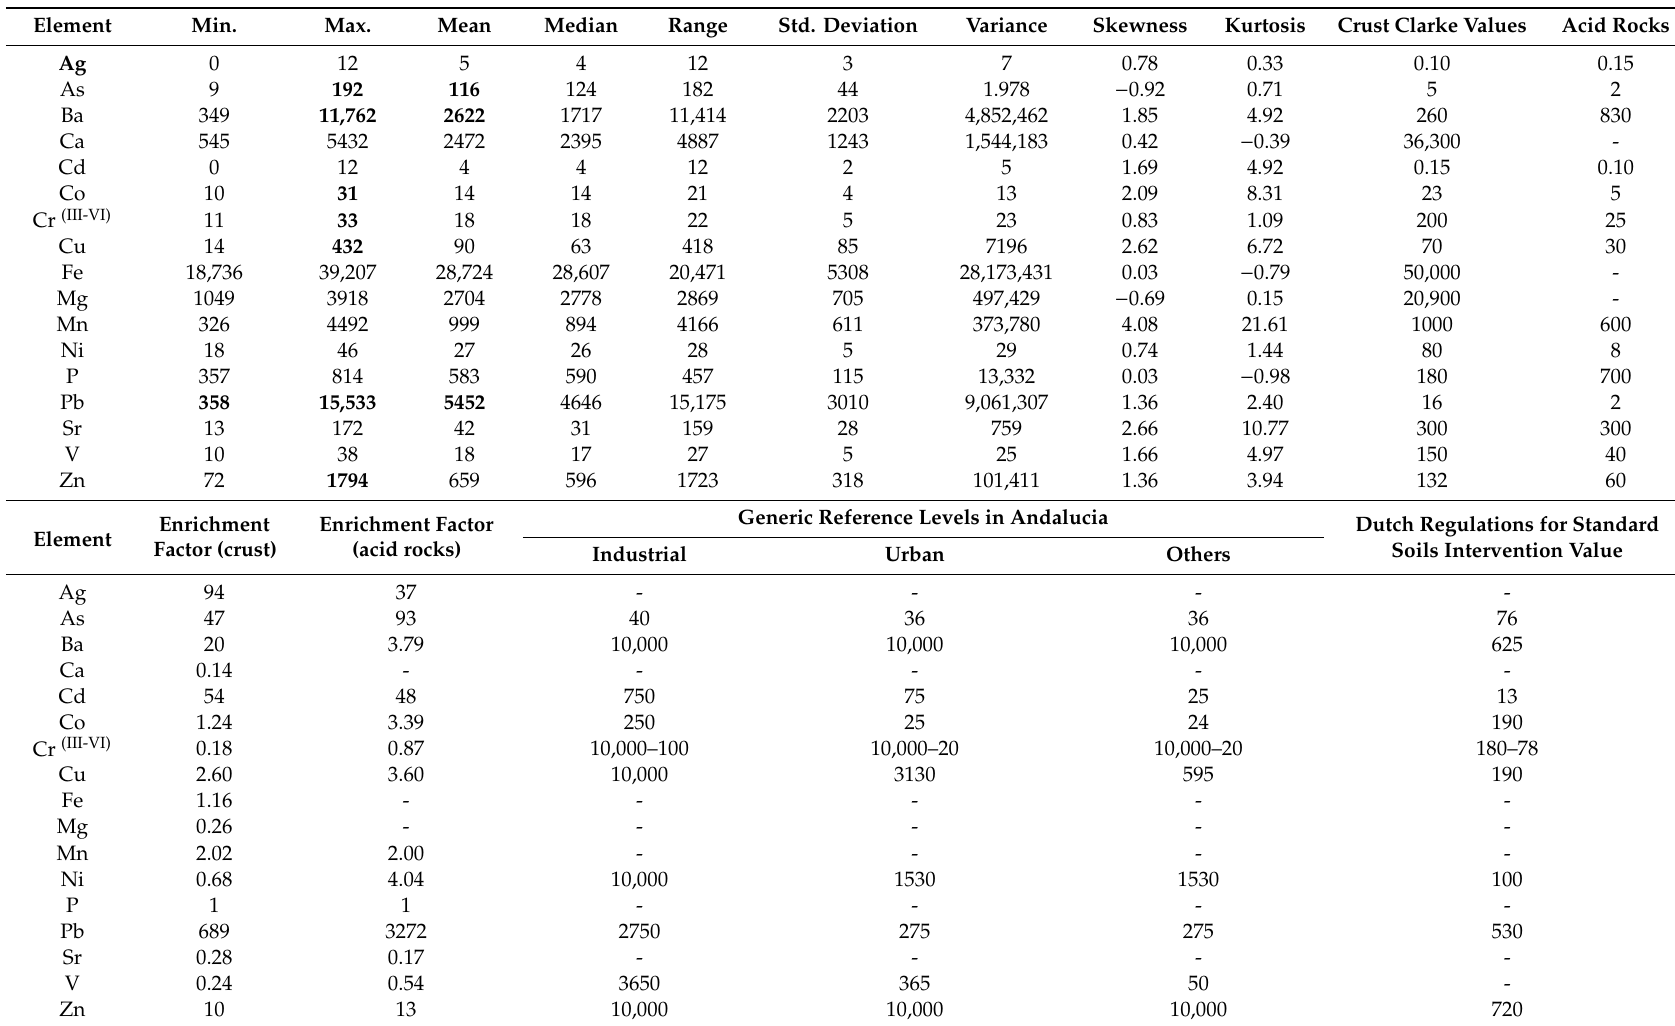
Table 2. Descriptive statistics of total concentrations: minimum maximum median range standard deviation (all data in mg kg) variance skewness and kurtosis. Enrichment factors referred to crust Clarke values and acid rocks are showed. Generic reference levels (GRL) established by the regional government (Junta de Andaluc í a 2015) and the Dutch soil standard (Dutch Ministry 2013) are also included. Concentrations above the reference values are in